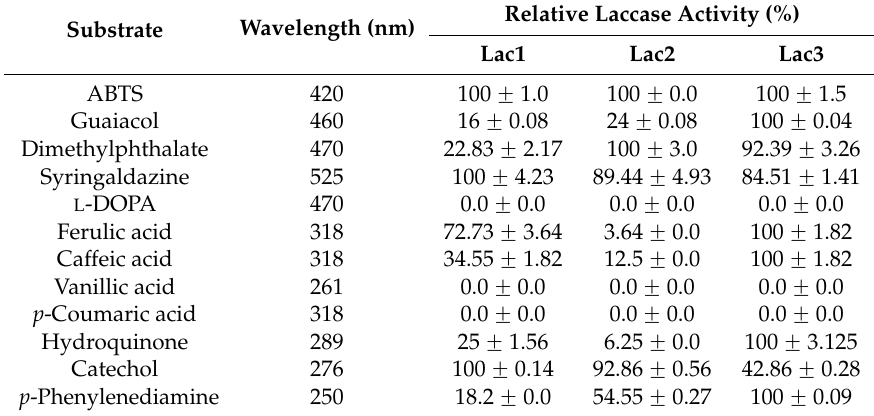
Table 2. Substrate specificities of purified P. nebrodensis laccases.